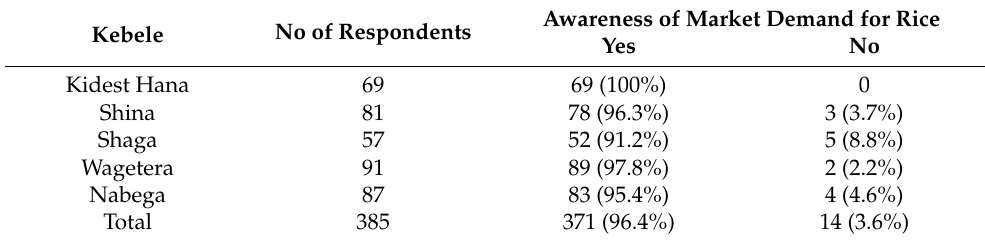
Awareness of Market Demand for Rice Yes No